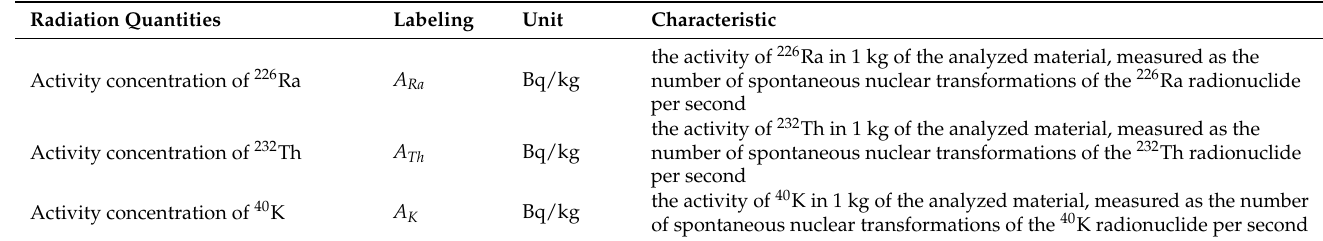
Table 1. Measured radiation quantities and their characterization.